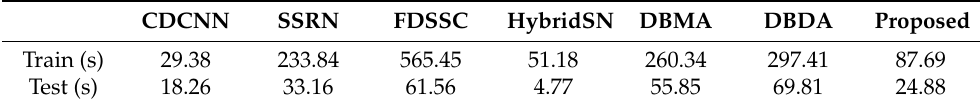
Table 13. The training time and test time in seconds (s) for different methods on the SA dataset. CDCNN SSRN FDSSC DBDA Proposed Train